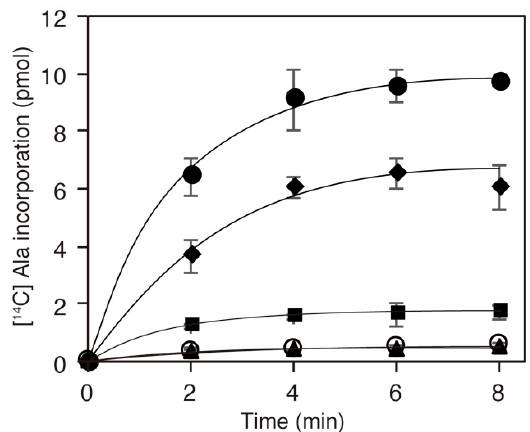
Figure 3. Alanylation activities of E. coli AlaRS K73Ac variants. In vitro transcribed E. coli tRNA Ala was alanylated with AlaRS WT (filled circles), K73A (opened circles), K73Ac (NAM − ; diamonds), K73Ac (NAM+; squares), and K73Ac ( ∆ CobB; triangles). The data is shown as the average of three independent assays with the standard deviations.